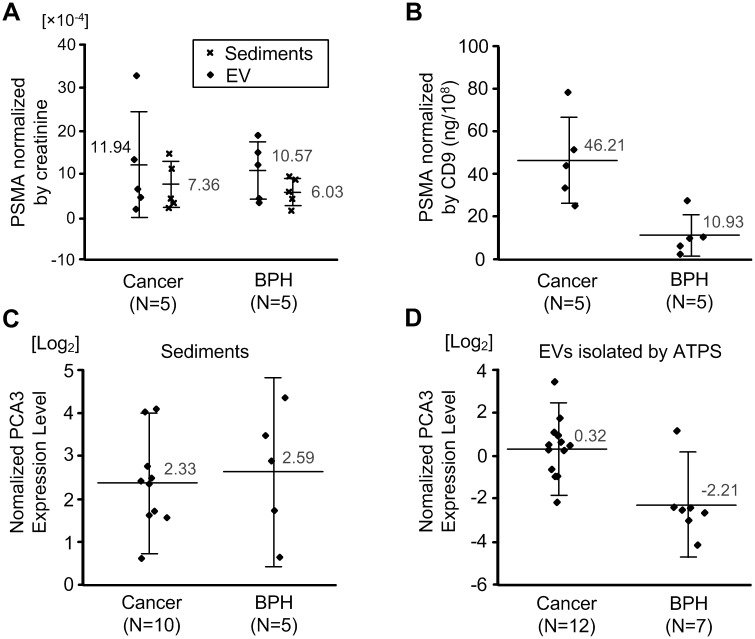
Prostate cancer-associated gene expression using ATPS and sediments.(A) Amounts of prostate-specific membrane antigen (PSMA) (normalized by creatinine concentration in urine) obtained using sedimentation and EVs isolated by ATPS in prostate cancer (PCA) and prostate hyperplasia (BPH) patients. (B) Amounts of prostate-specific membrane antigen (PSMA) (normalized by CD9) obtained using EVs isolated by ATPS in PCA and BPH groups. (C) RNA expression level of prostate cancer antigen 3 (PCA3) (normalized by actin) obtained using sedimentation in PCA and BPH groups; y-axis scale is log2. Large value means that PCA3 was highly expressed. (D) RNA expression level of PCA3 (normalized by actin) in EVs obtained using ATPS, in PCA and BPH groups. qPCR was performed to measure gene expression levels.